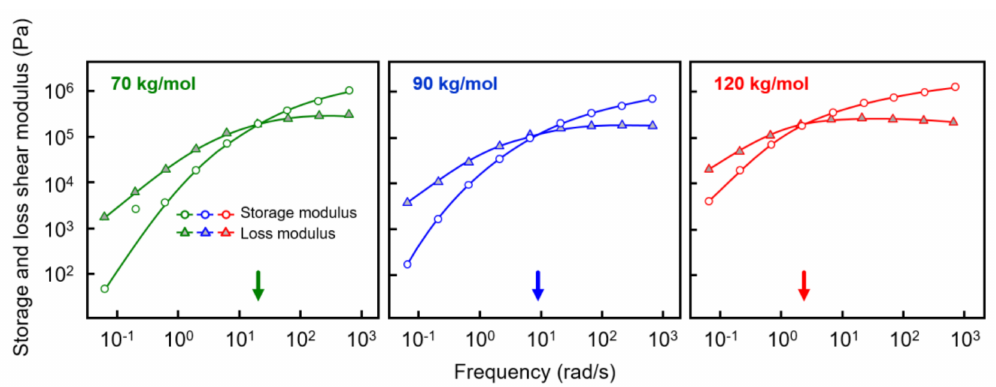
Figure 2. Storage (open circles) and loss shear modulus (gray triangles) of PLLA of molar mass of 70 ( left ), 90 ( center ), and 120 kg/mol ( right ), as a function of frequency at 135 ◦ C. The colored arrows at the frequency axes indicate the relaxation times of the various